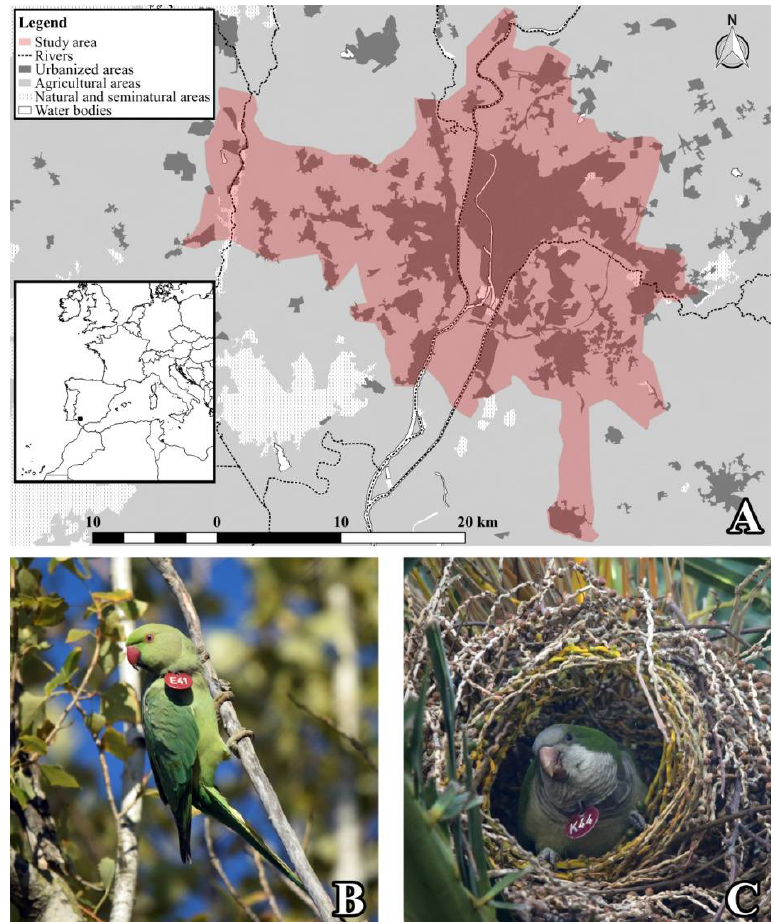
Figure 1. ( A ) Location of the study area in the metropolitan area of Seville (southern Spain). ( B ) A rose-ringed ( Psittacula krameri ) and ( C ) a monk parakeet ( Myiopsitta monachus ) individually marked during our study period. Photos by D. Hernández-Brito.